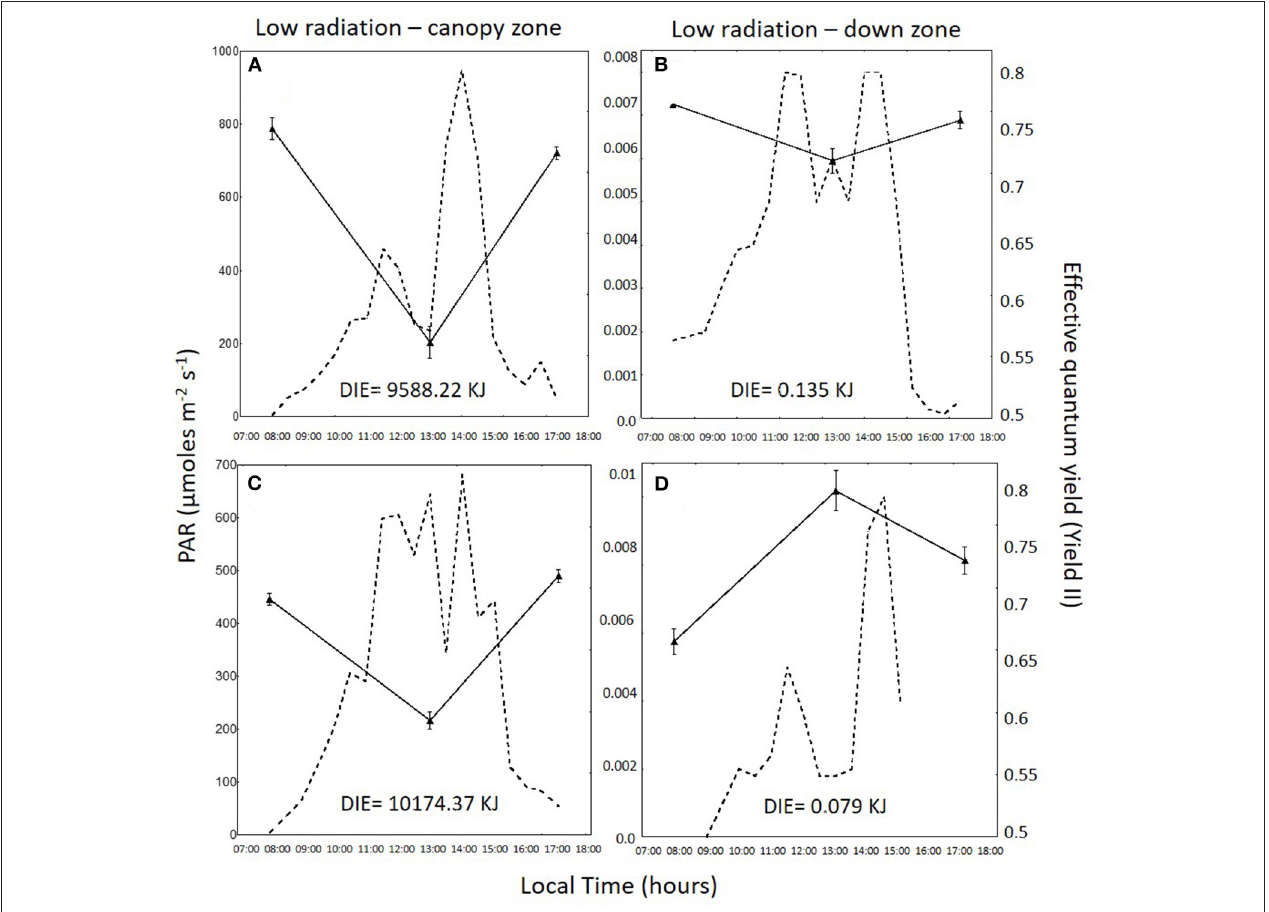
FIGURE 4 | Photosynthetically active radiation (PAR: 400–700nm, in µ mol photons m − 2 s − 1 , dotted lines) and the effective quantum yield ( Y II ) in Macrocystis pyrifera fronds (continuous lines) in the low-radiation treatment during the first daily cycle under the canopy zone (A) and the down zone (B) ; likewise, in the second daily cycle under the canopy zone (C) and the down zone (D)